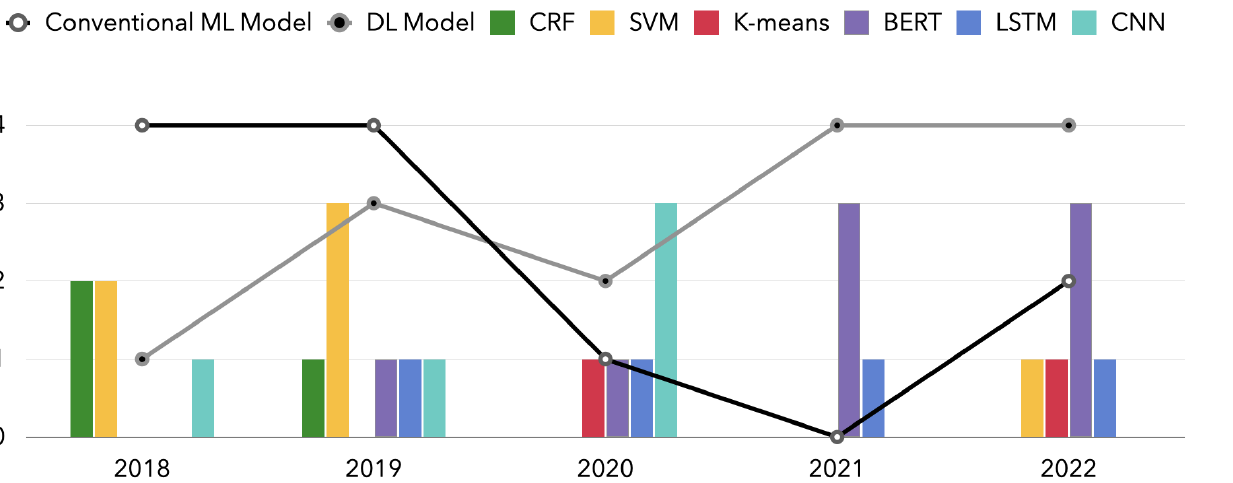
Table 8. The information of publications ’ dataset s. Private represents the dataset is not available. Public represents the dataset is available Reference